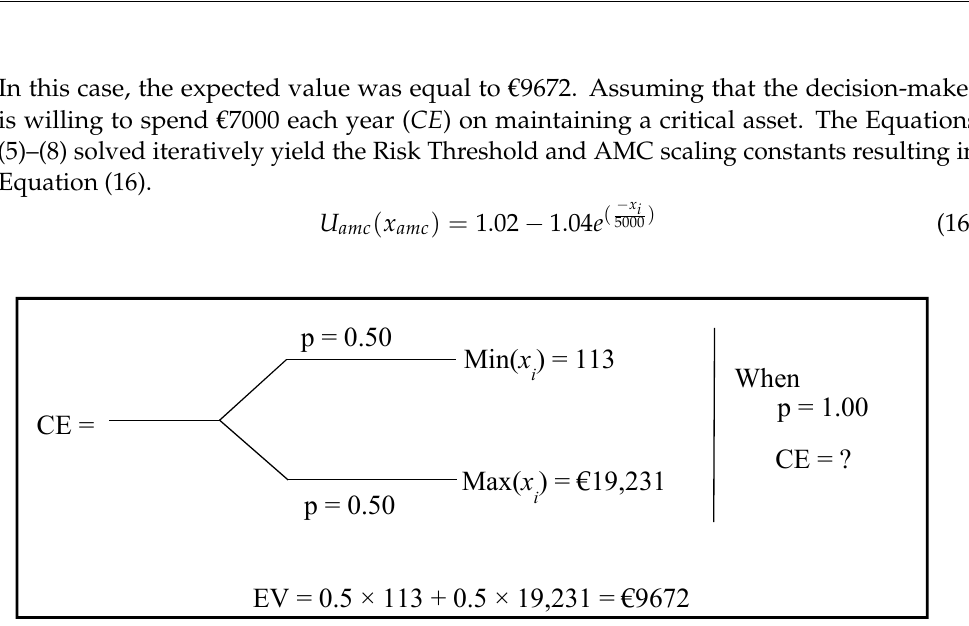
Figure 7. Utility plot of reliability benefit.